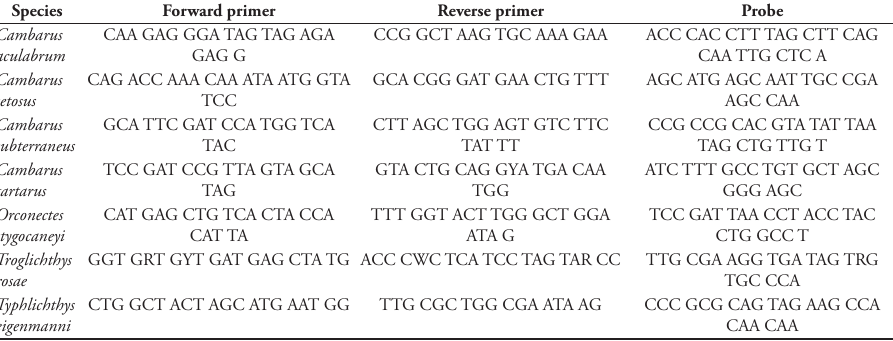
Table 1. Taqman assays were designed to amplify DNA for each of our target species. The 5' end of the probe was labeled with the fluorescent dye (6-FAM), the 3' primer end with a quencher (Iowa Black ™ FQ), and there was an additional internal quencher (ZEN ™ ). Probes were doubled quenched to reduce back- ground fluorescence and increase signal intensity. All primer and probe sequences are reported 5’ to